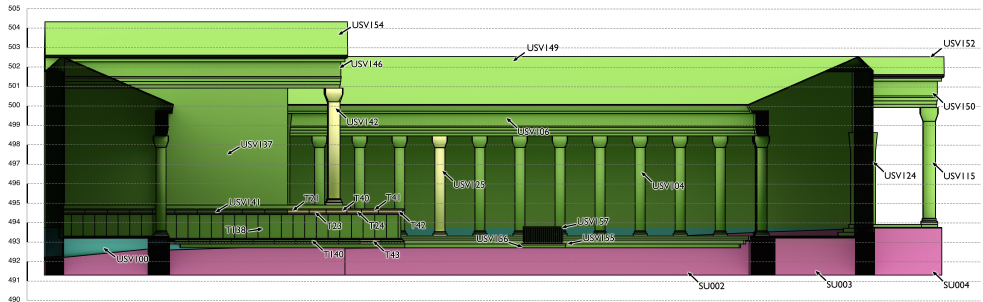
Figure 9. Section N-S of the Great Temple representing the proxy model and the SU/USV number’s. See colour chart in Table 3.